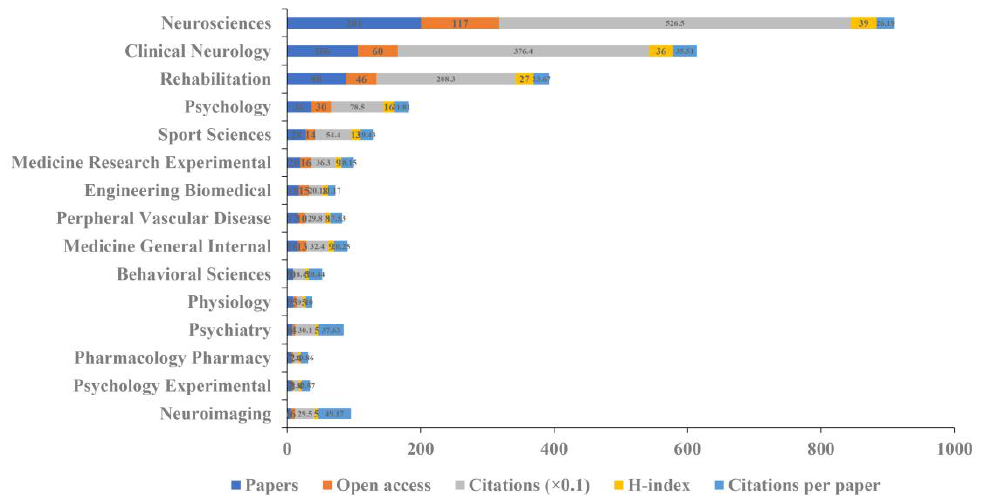
Figure 5. The amounts of papers, open access papers, citations, H-index, and citations per paper of the top 15 subject categories in the WoS.